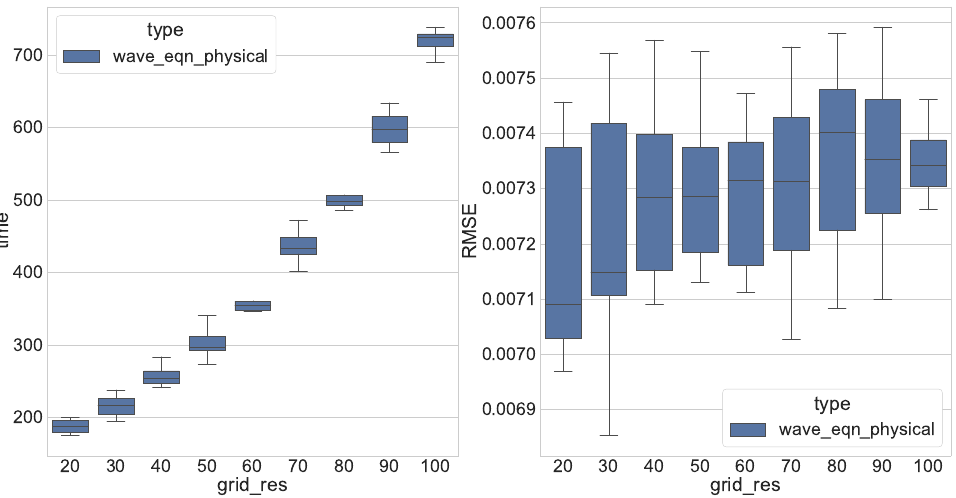
Figure 10. Results of the numerical solution to problem Equation (15) for a different number of discretization points. Computation time ( left ) and RMSE ( right ). All experiments were performed with cache=True